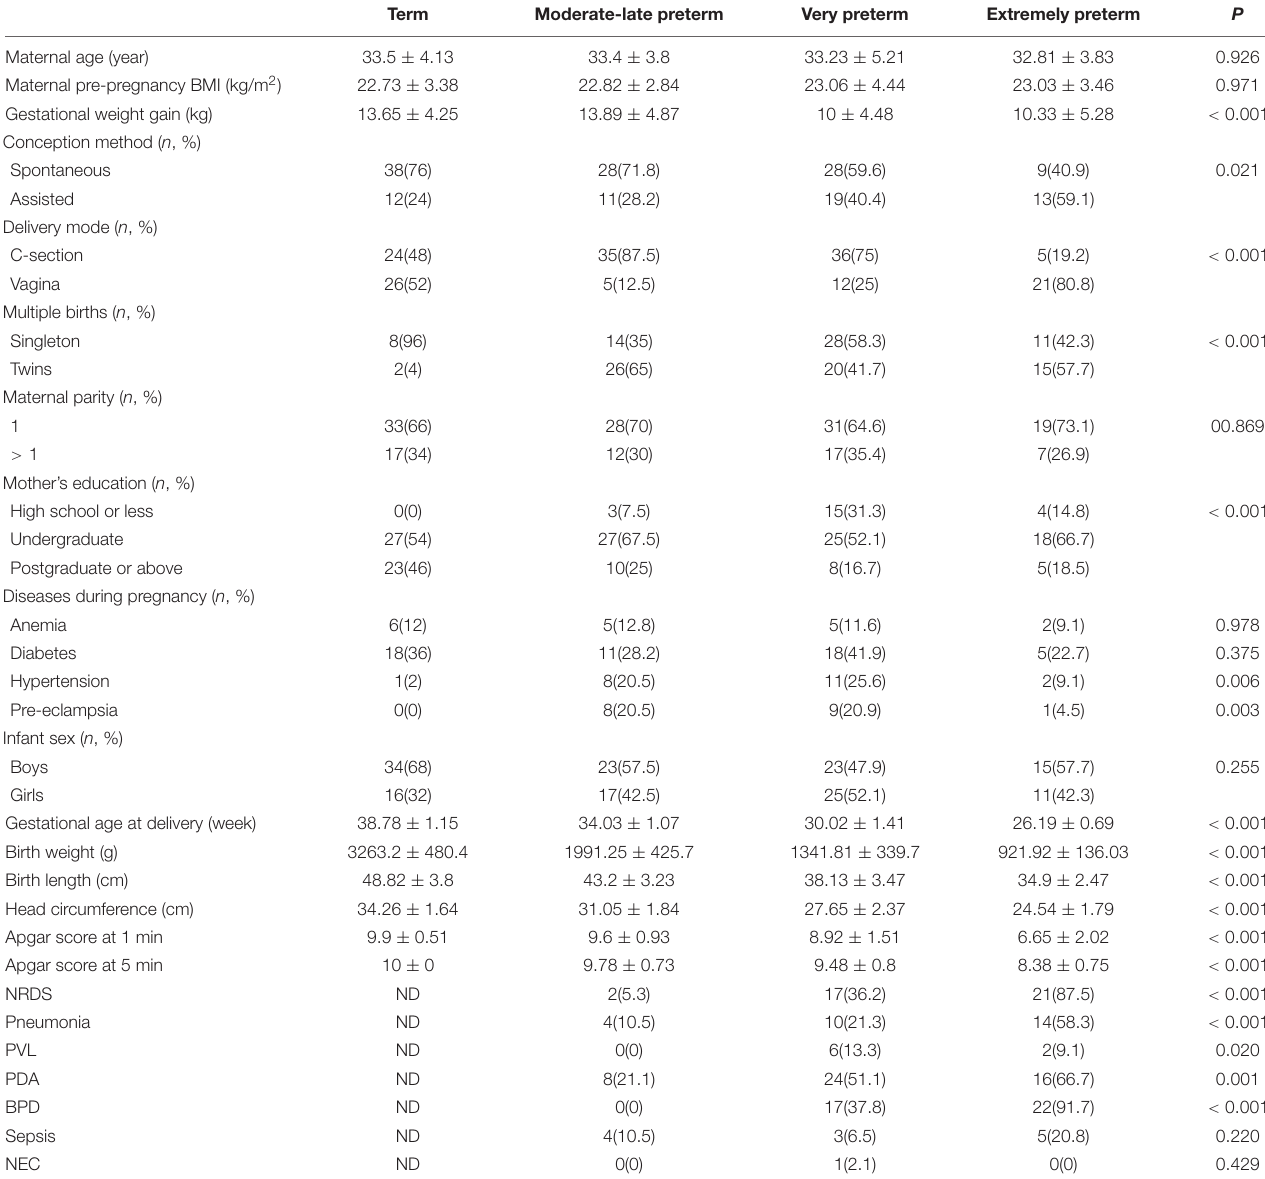
TABLE 1 | Clinical manifestation of mothers and